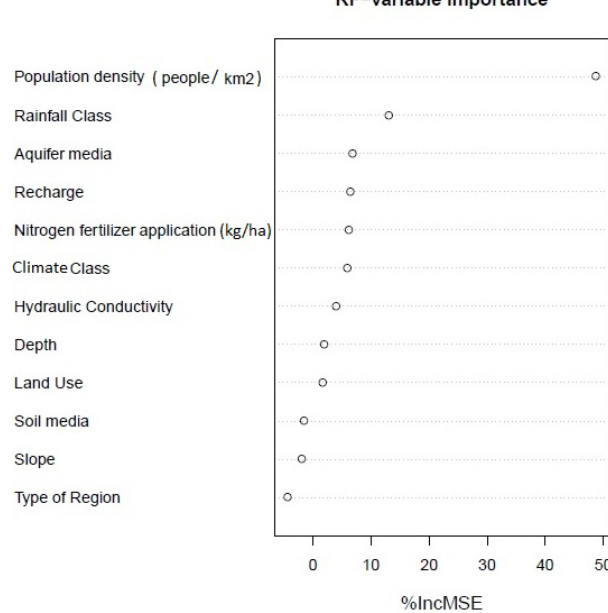
Figure 3. Variable importance section in Random Forest (RF) re-